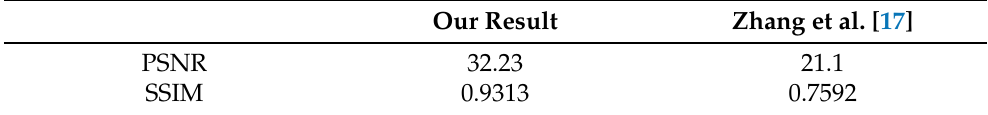
Table 3. For comparison with Zhang et al. [17], we evaluate the average PSNR and SSIM for only horizontal for all images in the dataset as the algorithm only synthesizes horizontal views.